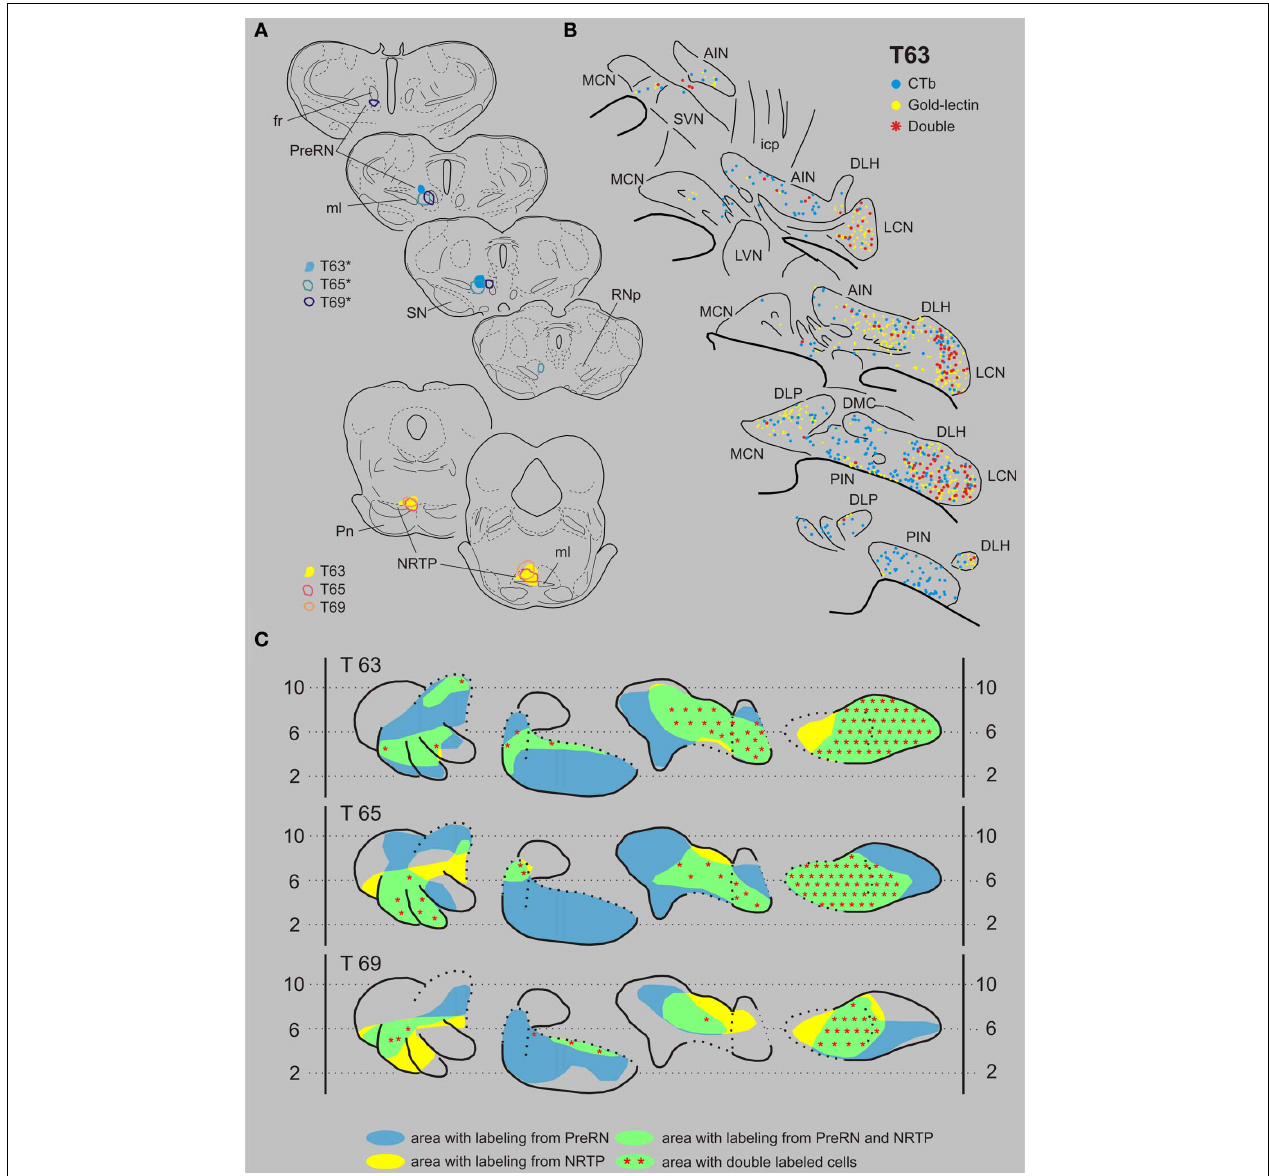
FIGURE 7 | Diagrams depicting results of the combination NRTP and the PreRN. (A) Injection sites of all three analyzed cases. Upper left hand panels show the injection sites within transverse diagrams of the mesodiencephalon. Bottom panels show the related injections sites in the NRTP. CTb injections (case number indicated with ∗ ) were made in the PreRN of all three cases. (B) Plots of 5 equidistant (320 micron) sections showing labeled neurons within the